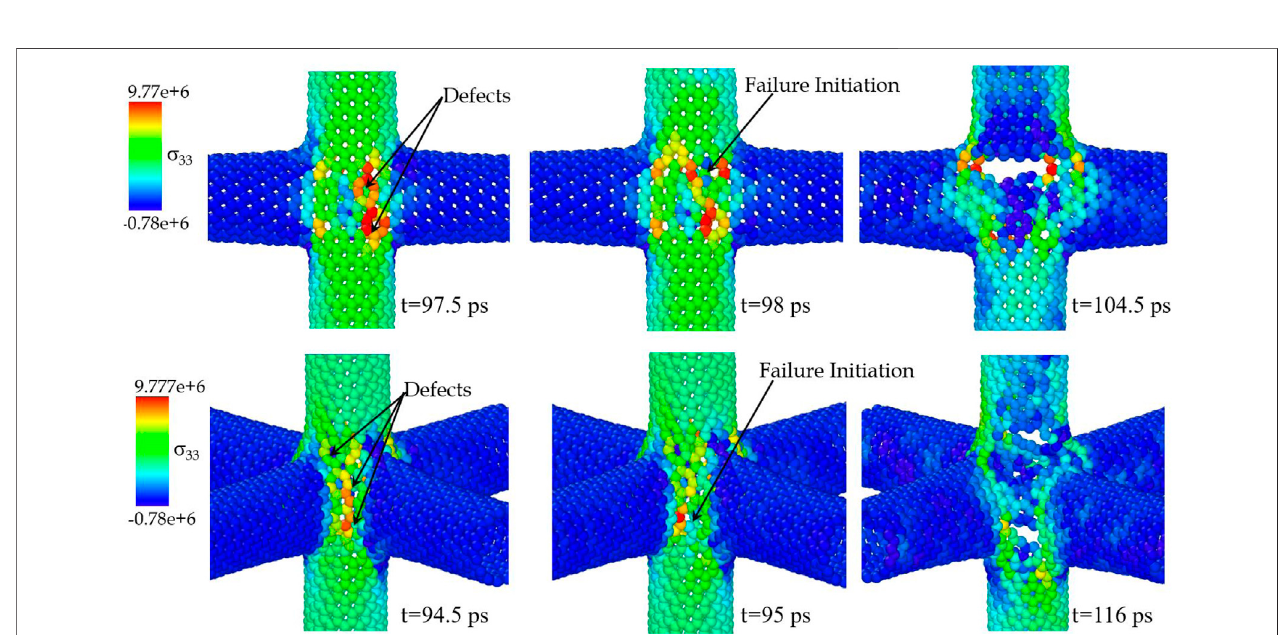
FIGURE 16 | Atomic stresses in multi-terminal junctions during failure due to uniaxial tensile loading. The color map represents per-atom stress along vertical direction ( σ 33 , bars.Å 3 ) at 1 K